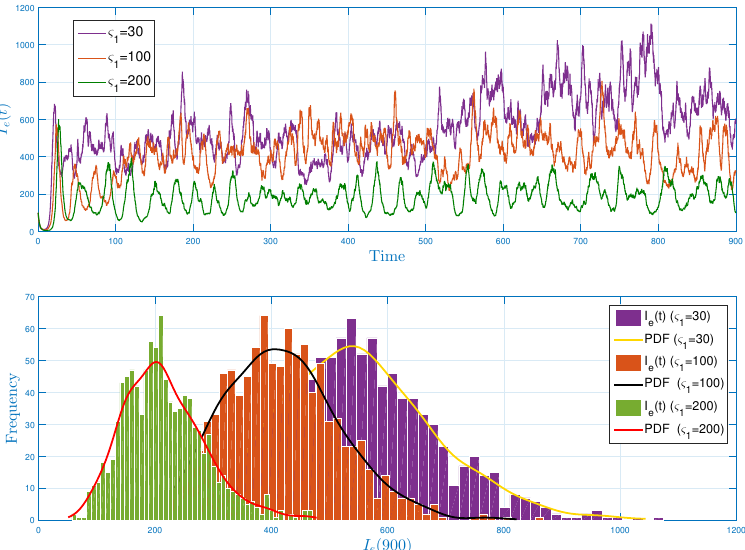
Figure 5. The first row represents the paths of the affected category for the following different time lags: ς 1 = 30, ς 1 = 100 and ς 1 = 200. The second row shows the associated histograms and the probability density functions for I s .